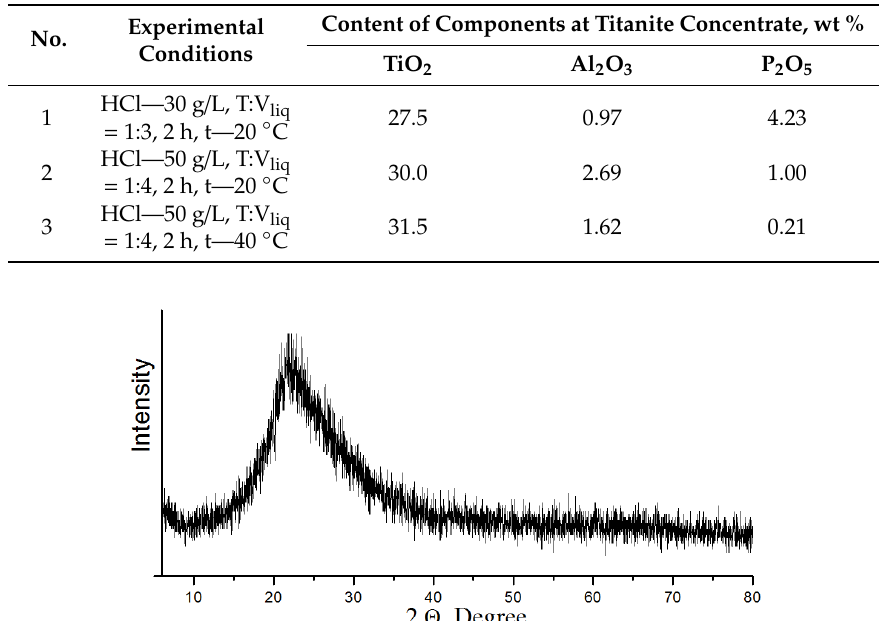
Figure 3. Technological scheme of processing titanium-containing mineral composition (TMC) to obtain weatherproof pigment and filler for glues and sealants. Table 2. Conditions and results of the TMC chemical treatment (content of components at initial